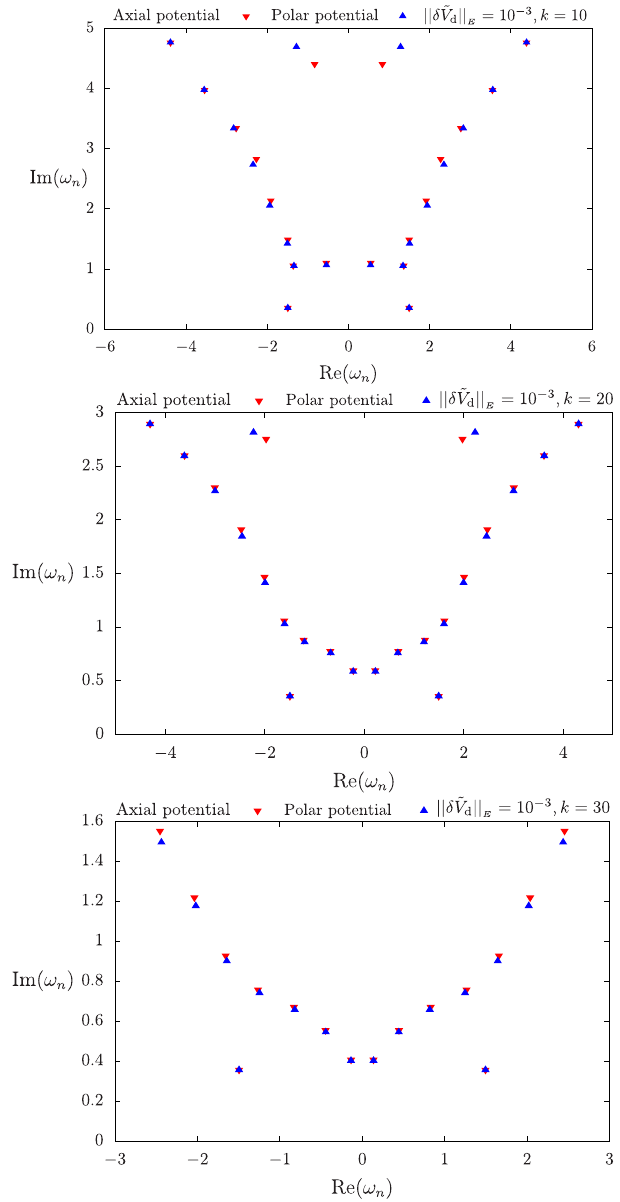
FIG. 15. Loss of QNM isospectrality in Schwarzschild spacetime, underhigh-frequencyperturbations.Thesequenceoffiguresshowsa zoom into the perturbation of lowest l ¼ 2 axial and polar QNM overtones (the branch cut has been removed), with δ value reaching the first overtone, and then increasing the frequency. The breaking of axial and polar isospectrality is demonstrated, with perturbed axial overtones slightly more dampedthanpolar perturbed counterparts, though both are over the same perturbed QNM branches (actually tracking the pseudospectra contour lines, cf. Fig. 17 below). The fundamental QNM remains unchanged, consistently with its stability, so the dominating ringdown frequency remains “ isospectral.